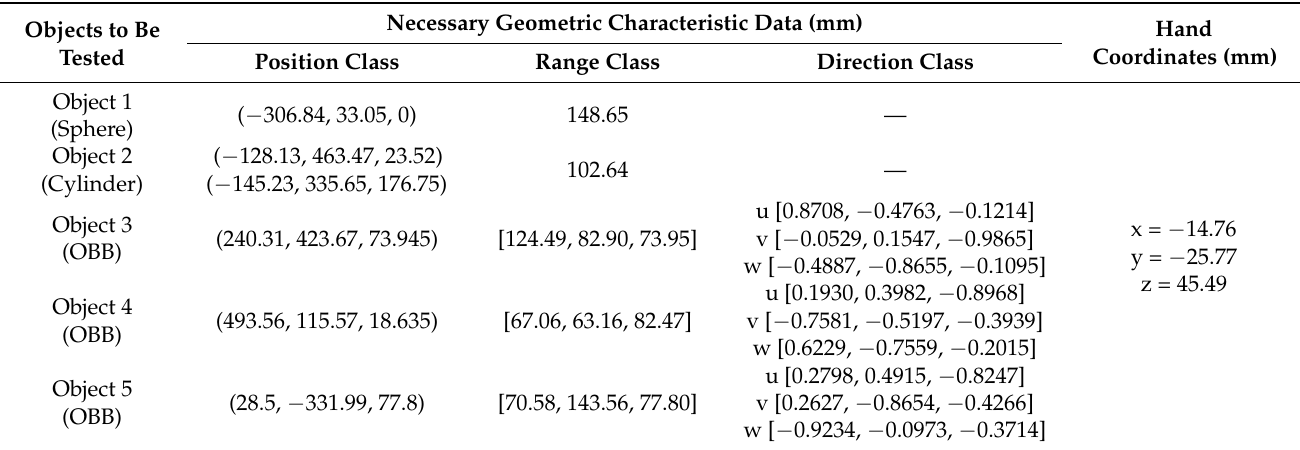
Table 4. Necessary Geometric Characteristic Data of the Object in Scene 2.